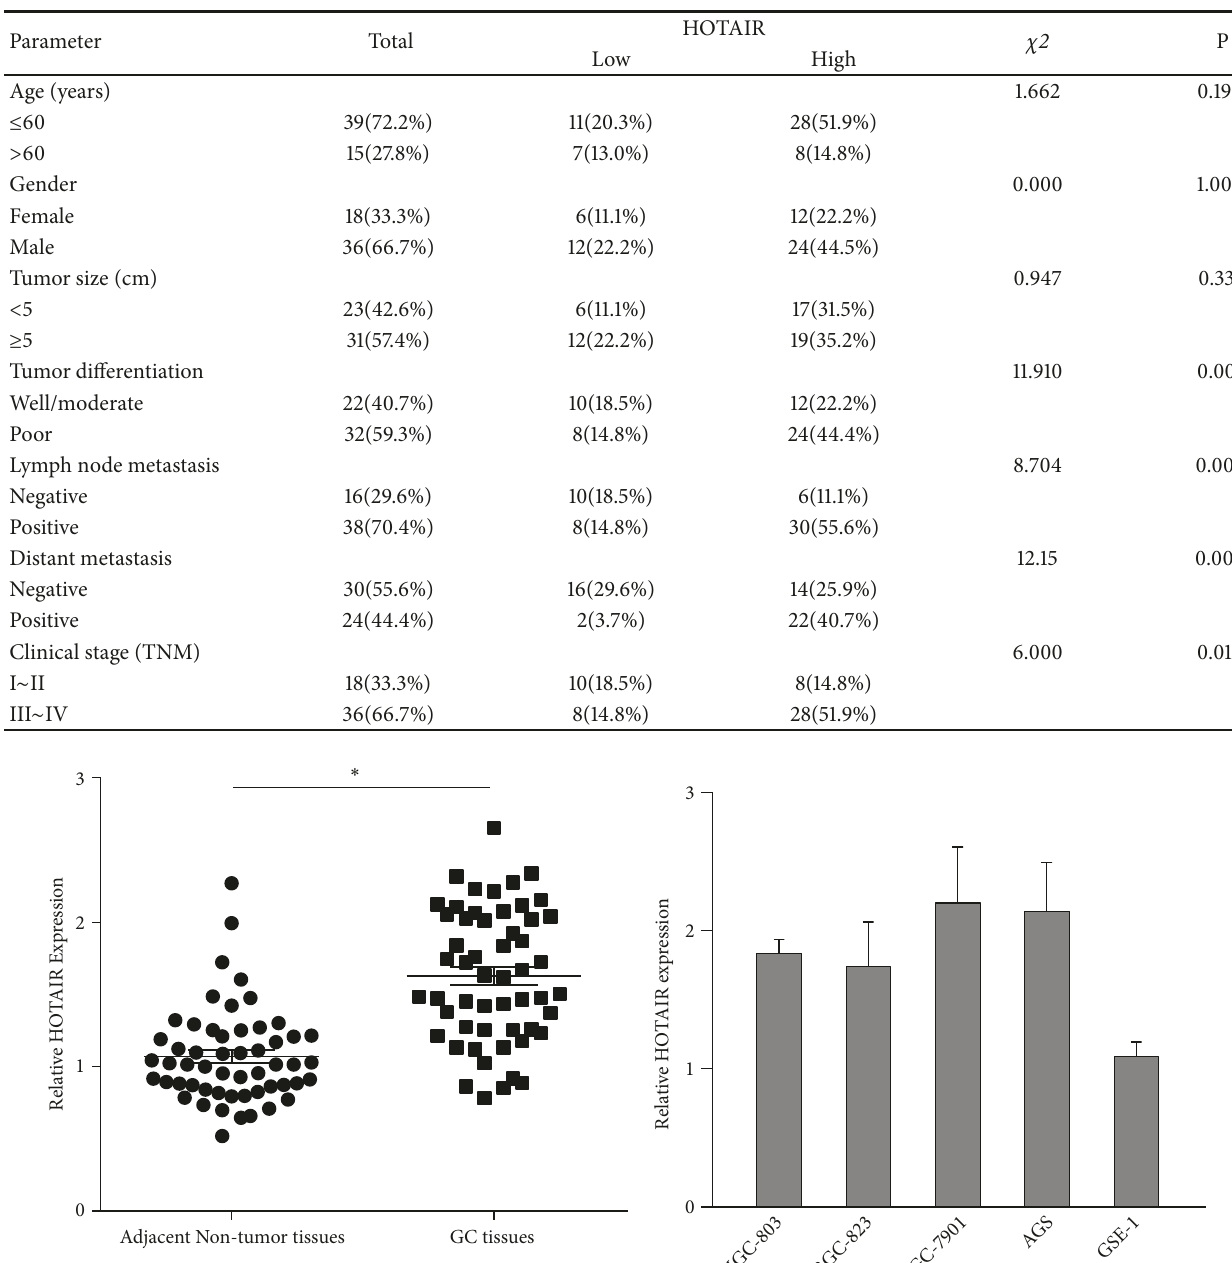
Table 1: Association of HOTAIR expression with clinical and pathologic features in GC patients.